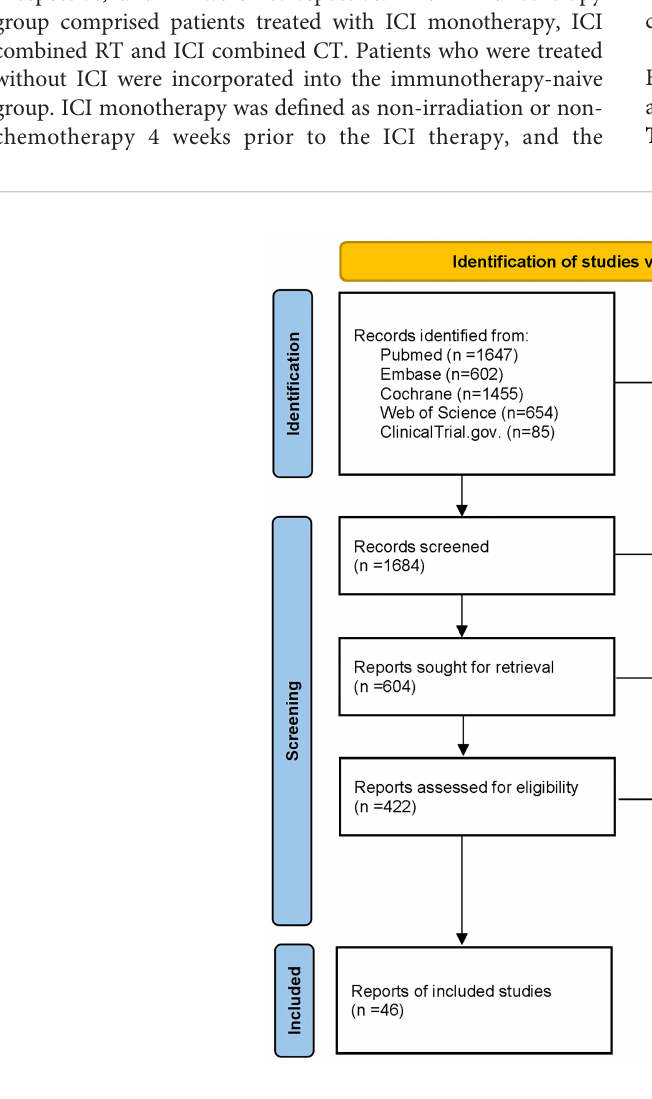
FIGURE 1 | Flow chart of study selection in the